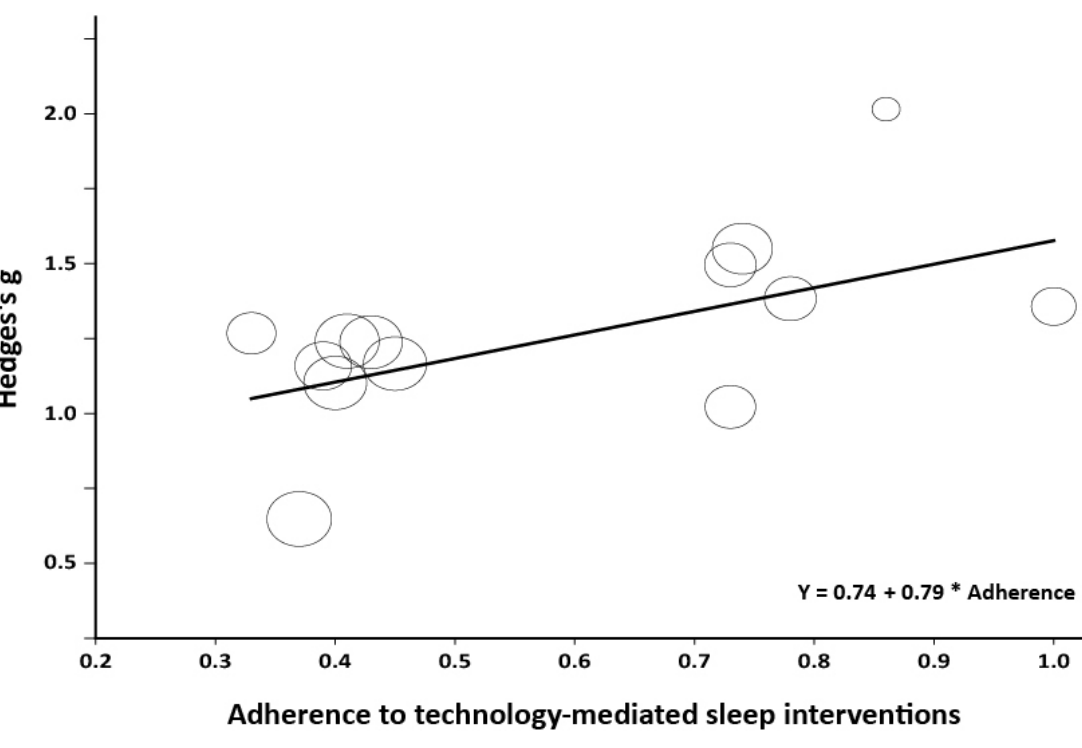
Figure 4. Meta-regression of adherence on effect size of treatments. The circles represent the individual studies [15-46]. The circle size indicates the weight of the study. The effect size is given in standard difference in